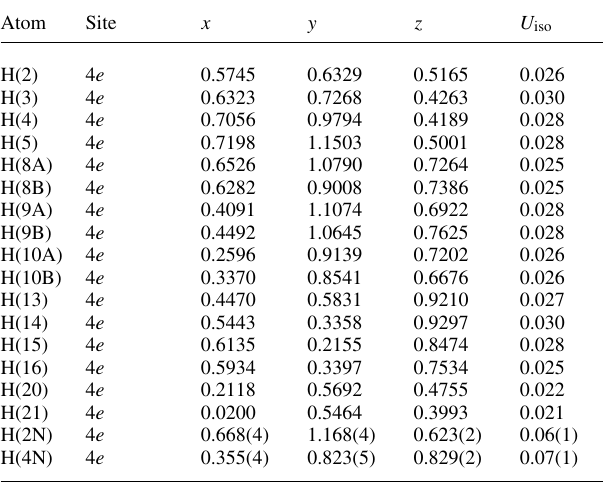
Table 2. Atomic coordinates and displacement parameters (in Å 2 )